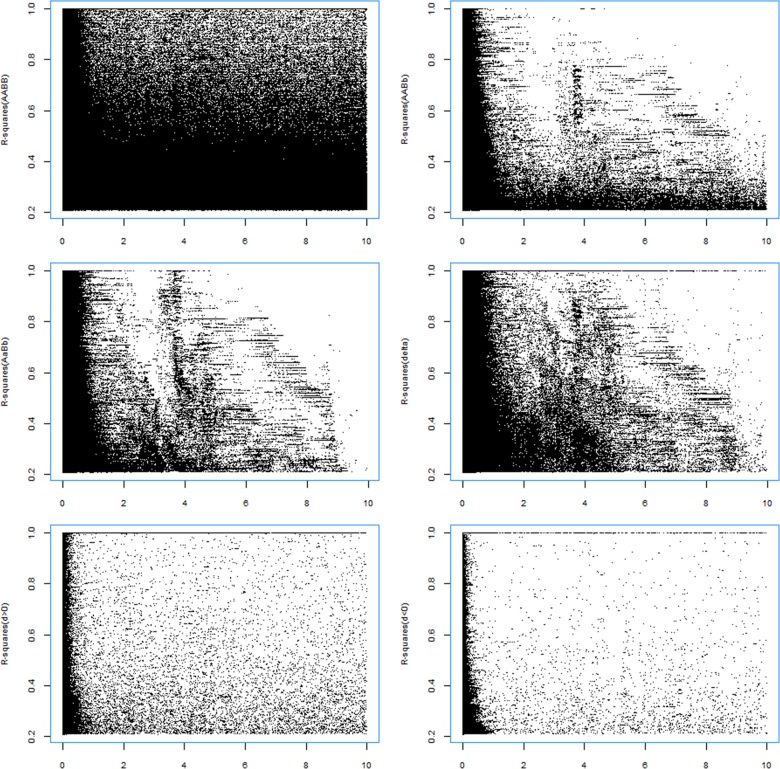
Pattern for the significant r-squares changing with the physical distances of SNP pairs (Mb) in population CEU.(a) D
AABB (6036652 pairs); (b) D
AABb (3647187 pairs); (c) D
AaBb (6893900 pairs); (d) the composite digenic LD (7130869 pairs); (e) the difference d >0 (116000 pairs); and (f) the difference d<0 (95921 pairs). The x-axis represents the physical distance between SNP pairs in Mb.